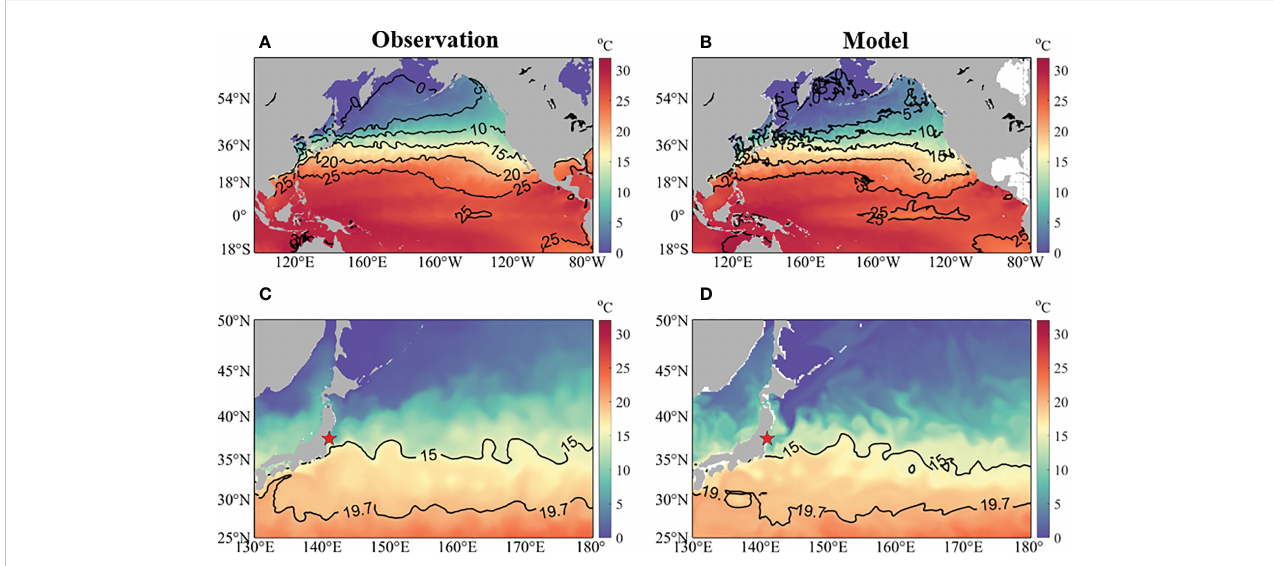
FIGURE 2 Comparison of the monthly mean sea surface temperature between (A, C) OSTIA and (B, D) model results in the (A, B) North Paci fi c and (C, D) western North Paci fi c in February 2012. The red star represents the FDNPP